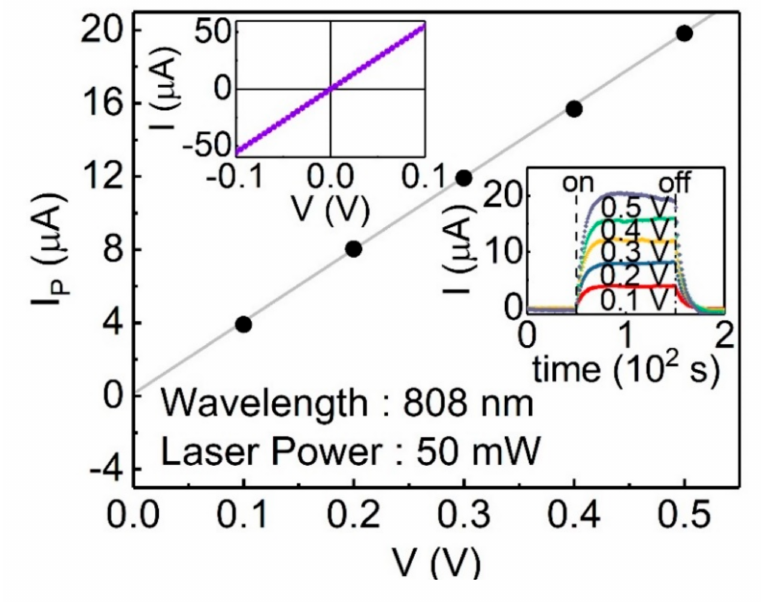
Figure 3. The left-top inset shows the linear current–voltage relationship, which indicates the ohmic contact between the Sb 2 Te 3 flake and Pt electrodes. The right-bottom inset shows the measured photocurrent at different applied voltages. The main figure shows the extracted photocurrent as a function of applied voltage. The photocurrent varies linearly with the applied